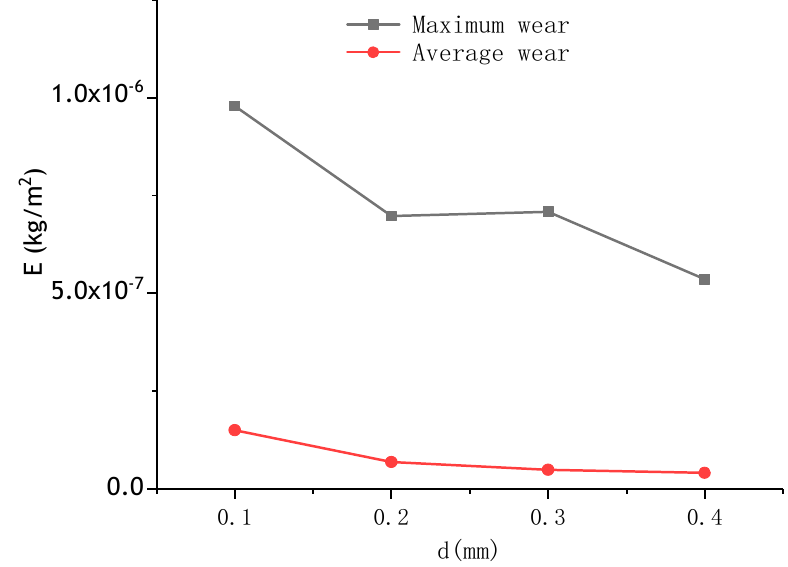
Figure 13. Wear curves of test samples under di ff erent particle